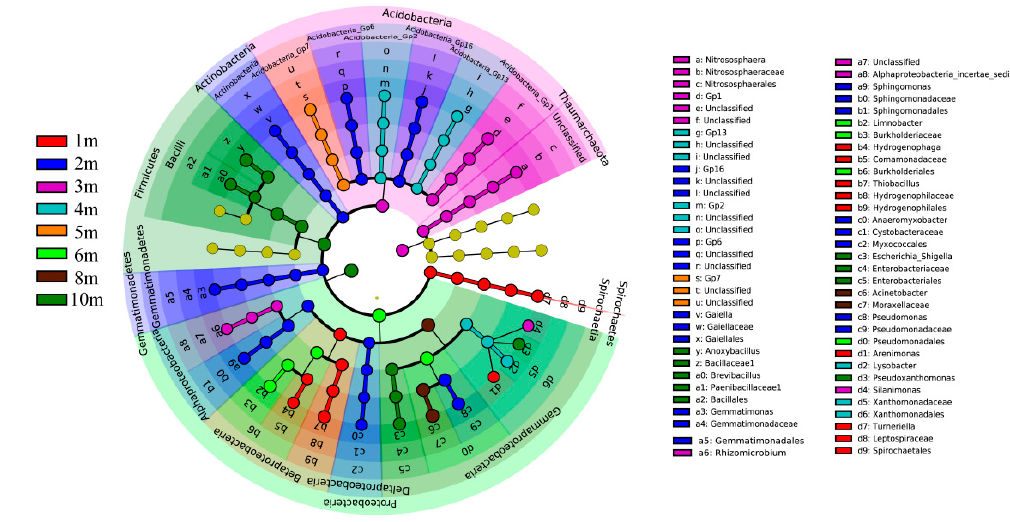
Figure 6. LEfSe analysis of soil samples at different depths (golden circles mean non-significant difference ( p > 0.05) in abundance among different soil depth layers; other colors mean biomarkers with significant differences ( p < 0.05) in different soil depth layers).